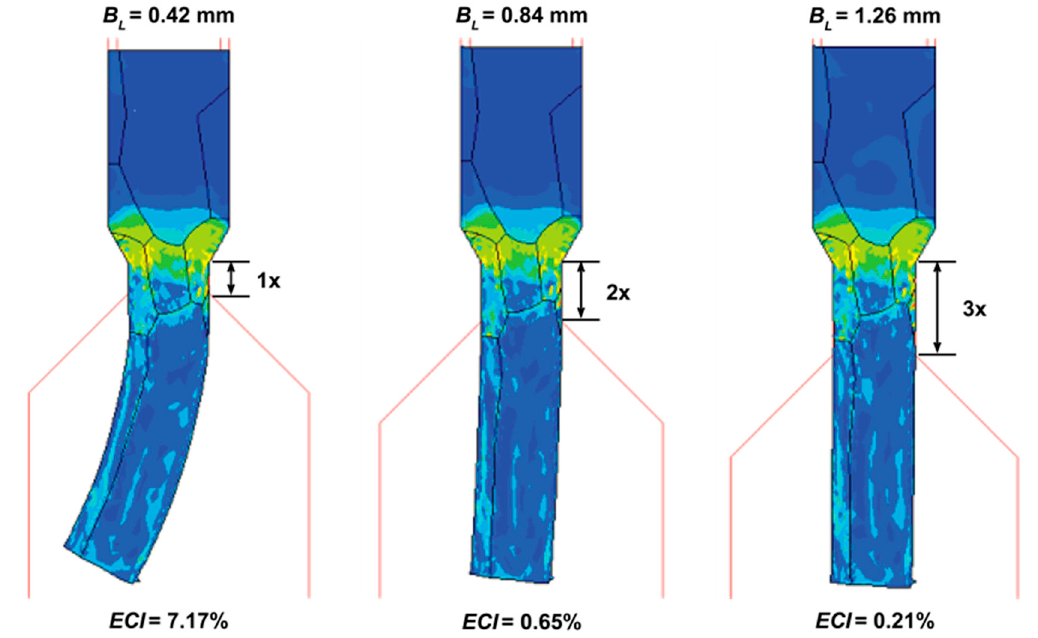
ff erent bearing